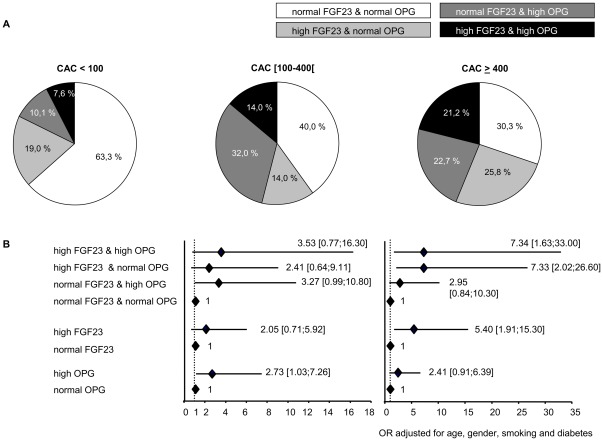
Fibroblast growth factor 23 and Osteoprotegerin are differently associated to the severity of CAC.(A) Proportions of patients with normal (<173.30 RU/mL) or high (≥173.30 RU/mL) fibroblast growth factor 23 (FGF23) and normal (<10.71 pmol/L) or high (≥10.71 pmol/L) osteoprotegerin (OPG) levels within each coronary artery calcification (CAC) category. Sections of pie charts indicate proportions of patients with FGF23 and/or OPG levels by CAC category. (B) Prevalence rate ratio of CAC associated with increased levels of FGF23 and/or OPG levels.